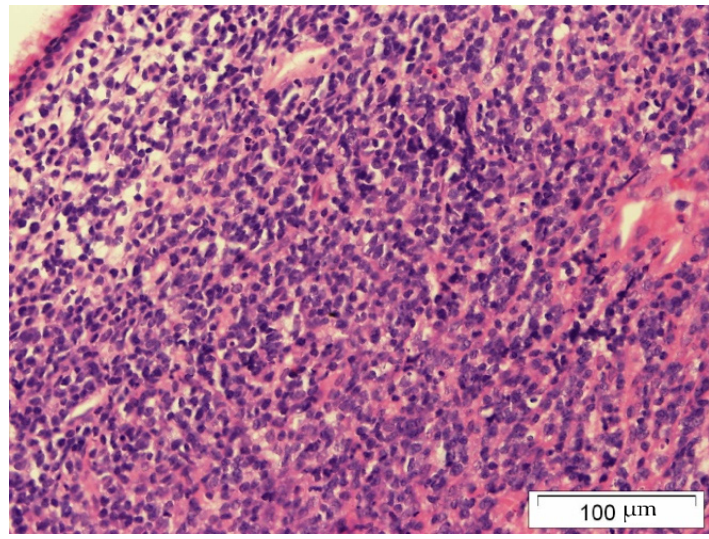
Figure 4. Tumor biopsy: HE staining.